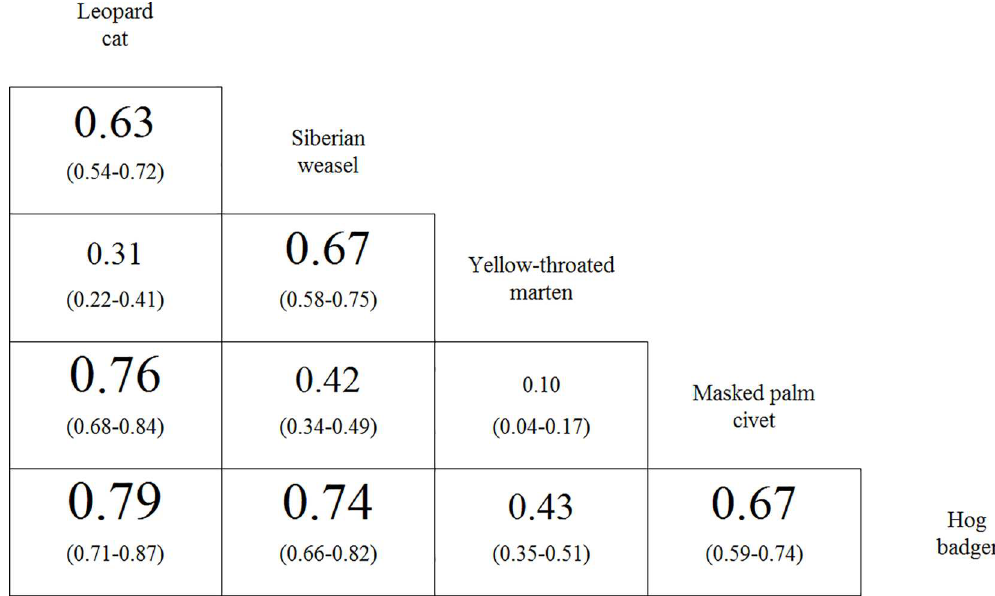
Fig 4. Diel activity overlap and confidence intervals for each species pair among the mesocarnivores during warm season in Minshan Mountains, Southwest China. The species are sorted from highly carnivorous(leopardcat) to omnivorous (Hog badger). The font size of the overlap value is proportional to its